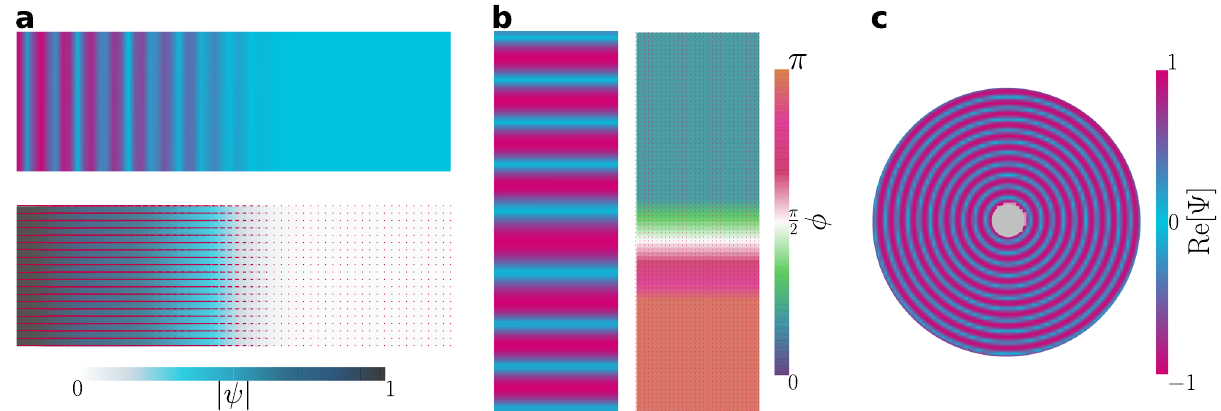
Fig. 2 | Smectic layer con fi gurations corresponding to changes to a single aspect of the order parameter. Smectic layers con fi gurations for a variety of con fi ning geometries at steady-state. C =2, κ 2 =0.6 and A = − 1, unless otherwise stated. a Modeling a temperature gradient in a channel, A increases linearly from lefttorightpassing through A =0atthe